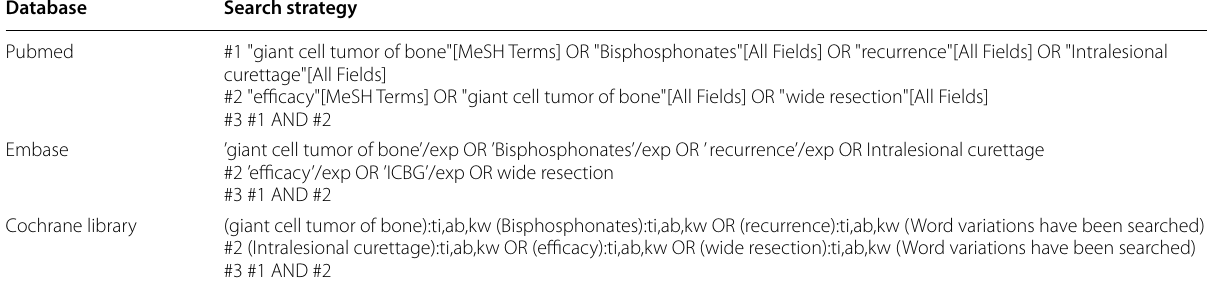
Table 1 Search strategy for each database